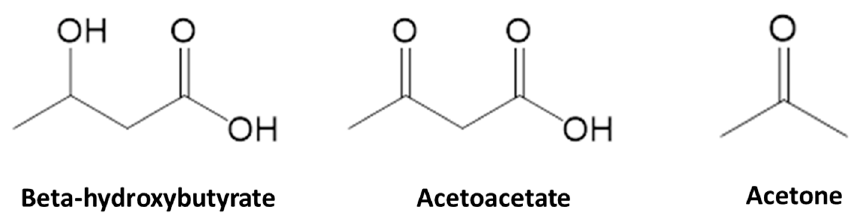
Figure 1. The chemical structures of the three ketone bodies. After β -hydroxybutyrate and acetoacetate enter the circulation, they will be reuptaken by other tissue cells via passive transport through monocarboxylate transporters 1 and 2 (MCT1, MCT2) for energy production purposes [26]. β -hydroxybutyrate is